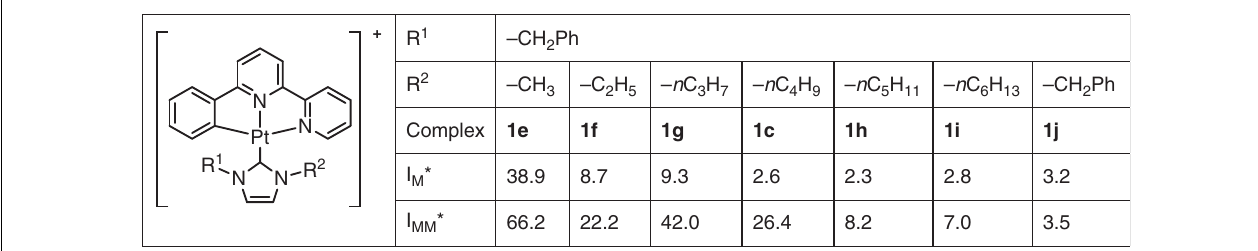
(Fig. 1; the X-ray crystallographic structure is depicted in